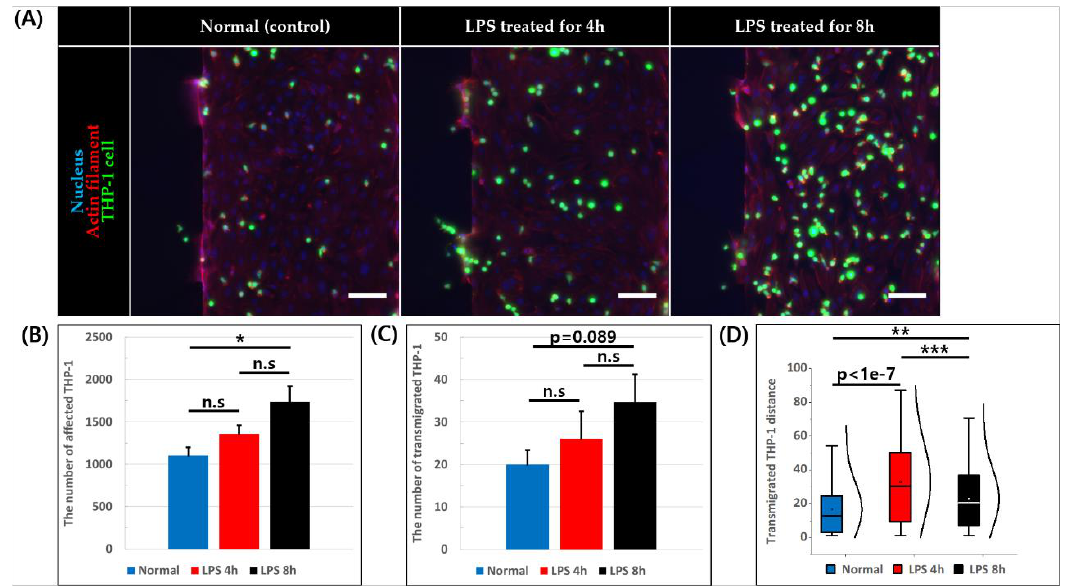
Figure 5. THP-1 adhesion and trans-endothelial migration assay. ( A ) Image of constructed blood vessel and adhered and migrated THP-1 stained for nucleus (blue), actin filament (red), and THP-1 (green), scale bar = 100 μm. ( B ) Number of adhered THP-1 to HUVEC monolayer and migrated THP-1 into collagen. (n = 4, n.s: not significant *: p < 0.05) ( C ) Number of transmigrated THP-1 across the endothelial monolayer into collagen. (n = 4, n.s: not significant) ( D ) Distance transmigrated THP-1 travelled measured by the distance between transmigrated THP-1 and HUVEC monolayer. (n = 80 from four devices for normal condition, n = 104 from four devices for LPS 4 h condition, n = 139 from 4 devices for LPS 8 h condition, **: p < 0.01, **: p < 0.001).